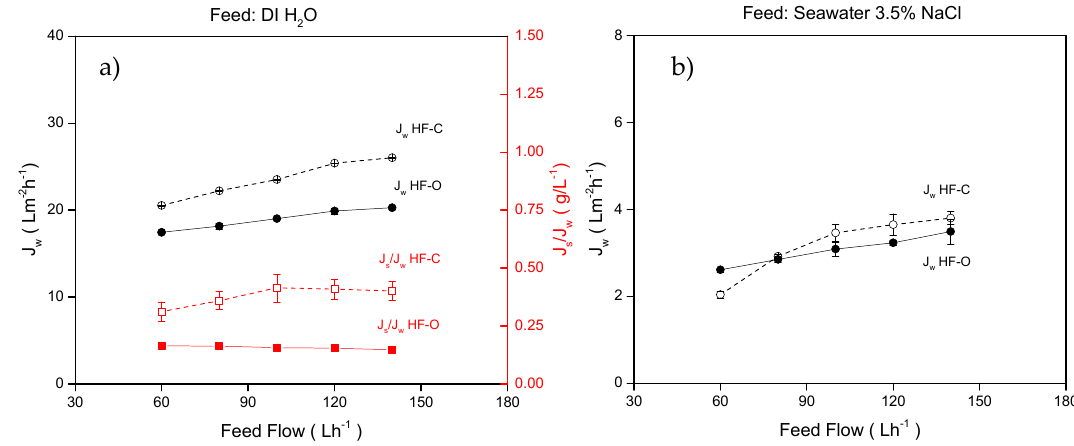
Figure 6. ( a ) J w and specific reverse solute flux (J s / J w ) for HF–C and HF–O modules as a function of feed flow rate when DI water was used as a feed solution (FS). ( b ) J w for HF–C and HF–O modules as a function of feed flow rate when 3.5% NaCl solution was used as a FS. Draw flow rate was 25 L · h − 1 , draw concentration was 1 M NaCl and TMP was 0.2 bar. (n = 2).